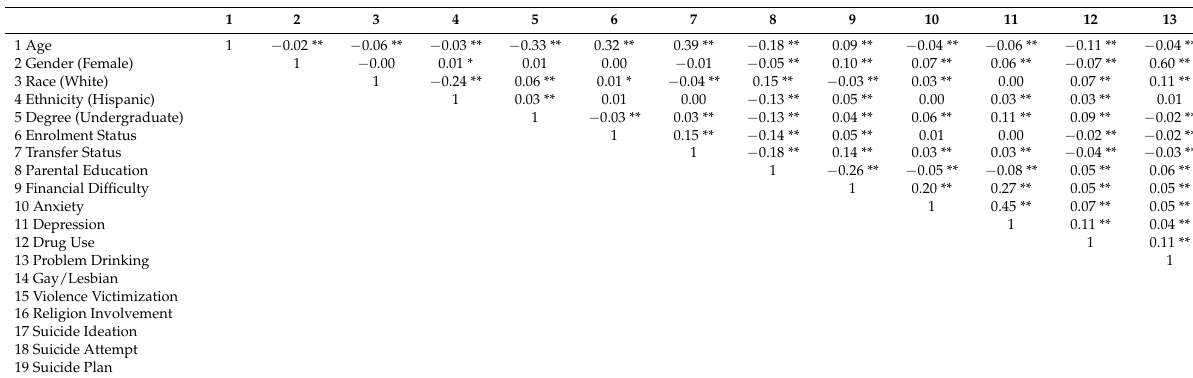
Table 2. Correlation matrix between